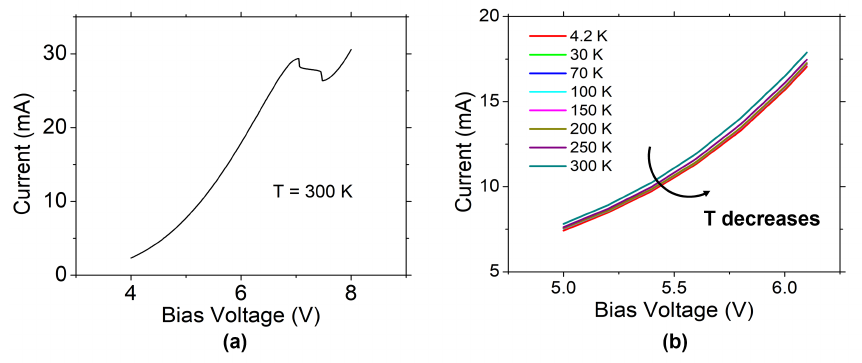
Figure 2. ( a ) I-V curve at room temperature, and ( b ) I-V curves at different temperatures. Figure 3a–e show spectral intensity Φ ( λ ) vs wavelength ( λ ) under four different biases: 5.2, 5.4, 5.6 and 5.8 volts at five temperatures: T = 4.2 K, 30 K, 70 K, 250 K and 300 K,